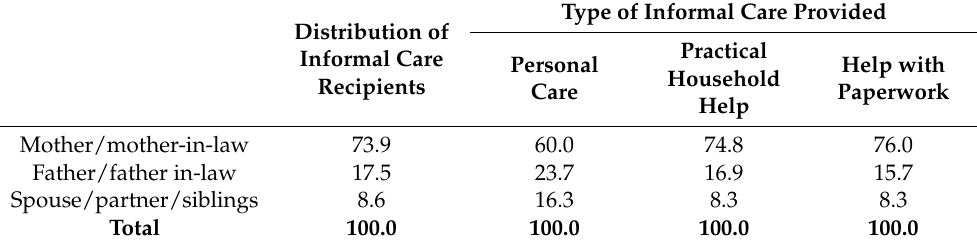
Table 1. Characteristics of informal care provided (percent).